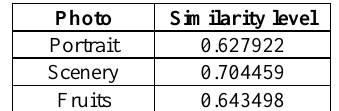
Table 1. The Frobenius-based similarity level for each test